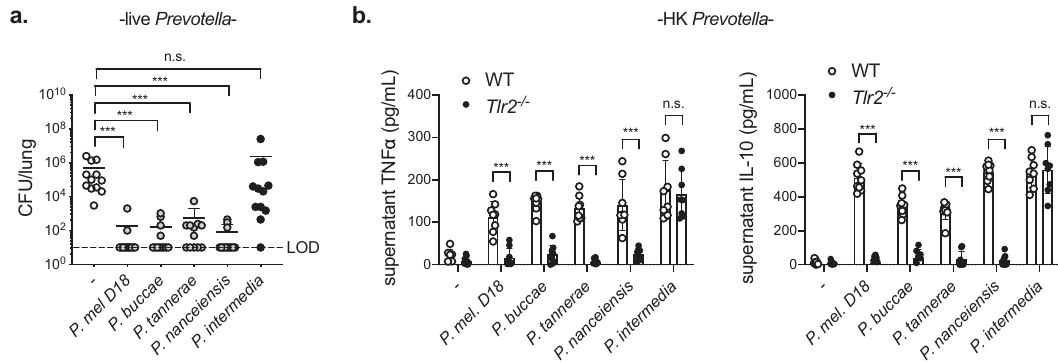
Fig. 9 Protection against S. pneumoniae is induced by other airway Prevotella that activate neutrophils in a TLR2-dependent manner. a Lung S. pneumoniae burdens in mice treated with PBS (-), live P. melaninogenica ( P. mel .) strain D18, live P. buccae , live P. tannerae , live P. nanceiensis , or live P. intermedia i.t. prior to 24 h S. pneumoniae infection, 5 × 10 6 CFU/mouse ( n = 12 mice/group). b Supernatant cytokines detected 24 h following incubation of BM neutrophils with P. mel . strain D18 heat-killed (HK), P. buccae HK, P. tannerae HK, P. nanceiensis HK, or P. intermedia HK ( n = 3 independent experiments/group). Data are pooled from three independent experiments, with cells plated in triplicate for in vitro studies, displayed as mean ± SEM. For a from left to right *** p < 0.0001, *** p < 0.0001, *** p = 0.0005, *** p < 0.0001, p = 0.9999, Kruskal – Wallis with Dunn ’ s post hoc test, b from left to right, *** p < 0.0001, *** p < 0.0001, *** p < 0.0001, *** p < 0.0001, p = 0.9959 (TNF α ), *** p < 0.0001, *** p < 0.0001, *** p < 0.0001, *** p < 0.0001, p = 0.9948 (IL-10), two-way ANOVA with Sidak ’ s post hoc test. Source data are provided as a Source Data fi